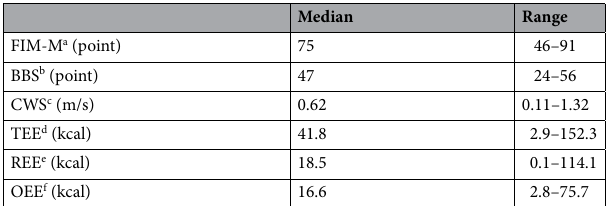
Table 2. Median and range of each physical function and energy expenditure (n = 36). a Functional Independence Measure Motor score. b Berg Balance Scale. c 10-m comfortable walking speed. d Total energy expenditure per day. e Energy expenditure during rehabilitation. f Energy expenditure other than during rehabilitation.